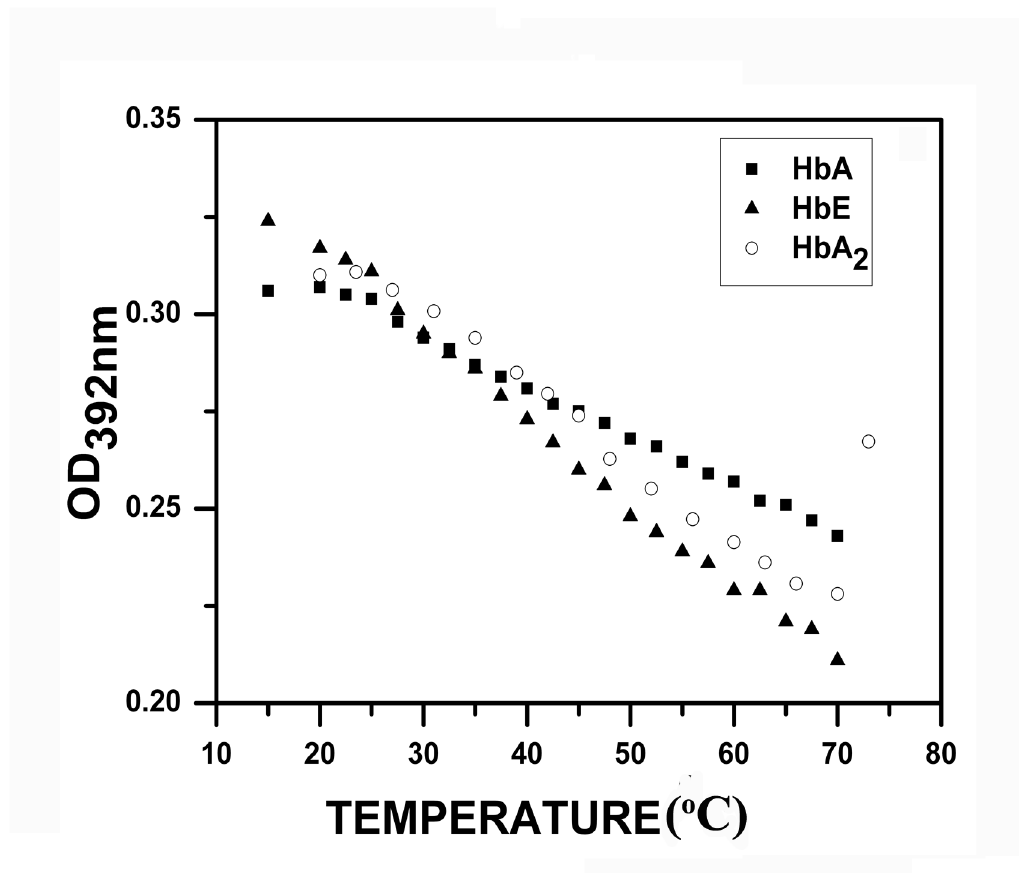
Figure 4. Change in absorbance in HbA, HbA lines indicate the order of thermal instability to be HbA>HbA 5 independent experiments which are of the order of the size of the